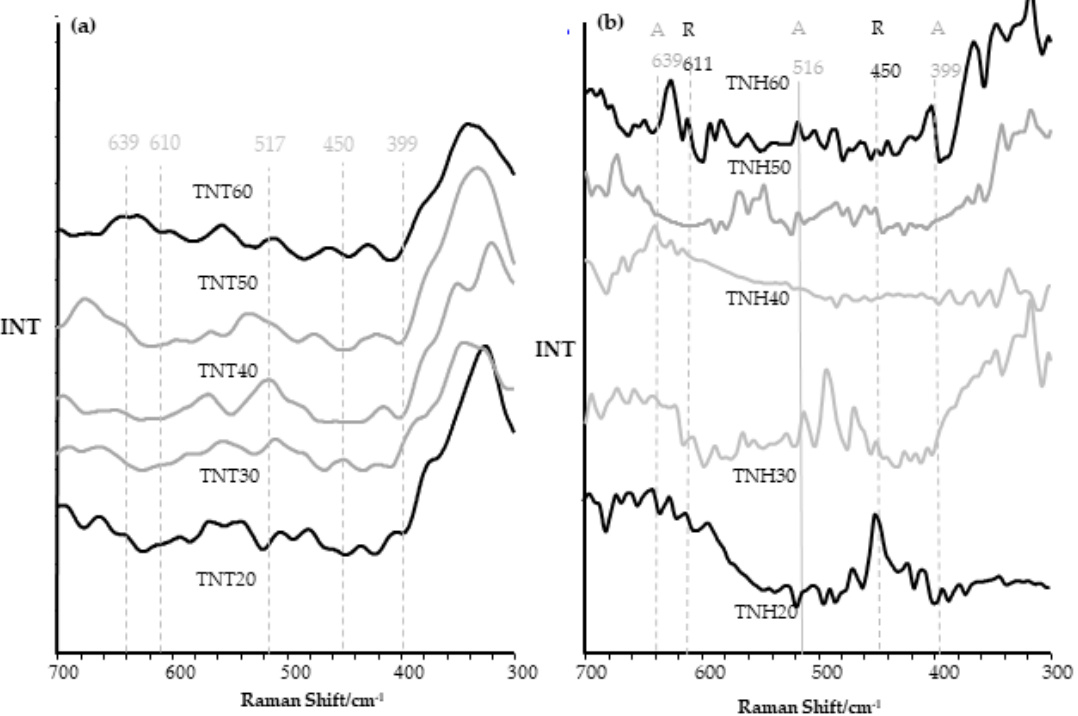
Figure 3. Raman spectra of Ti6Al4V/TNT20-60 ( a ) and Ti6Al4V/TNH20-TNT60 ( b ) samples (A—TiO 2 anatase form, R—TiO 2 rutile form).